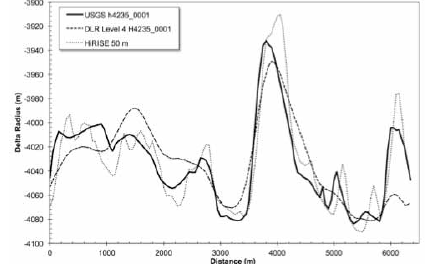
Figure 6. Sample profiles in Gale crater illustrating the differences in resolution between USGS and standard HRSC Team DTMs and the HiRISE DTM (downsampled from 1 m to 50 m per